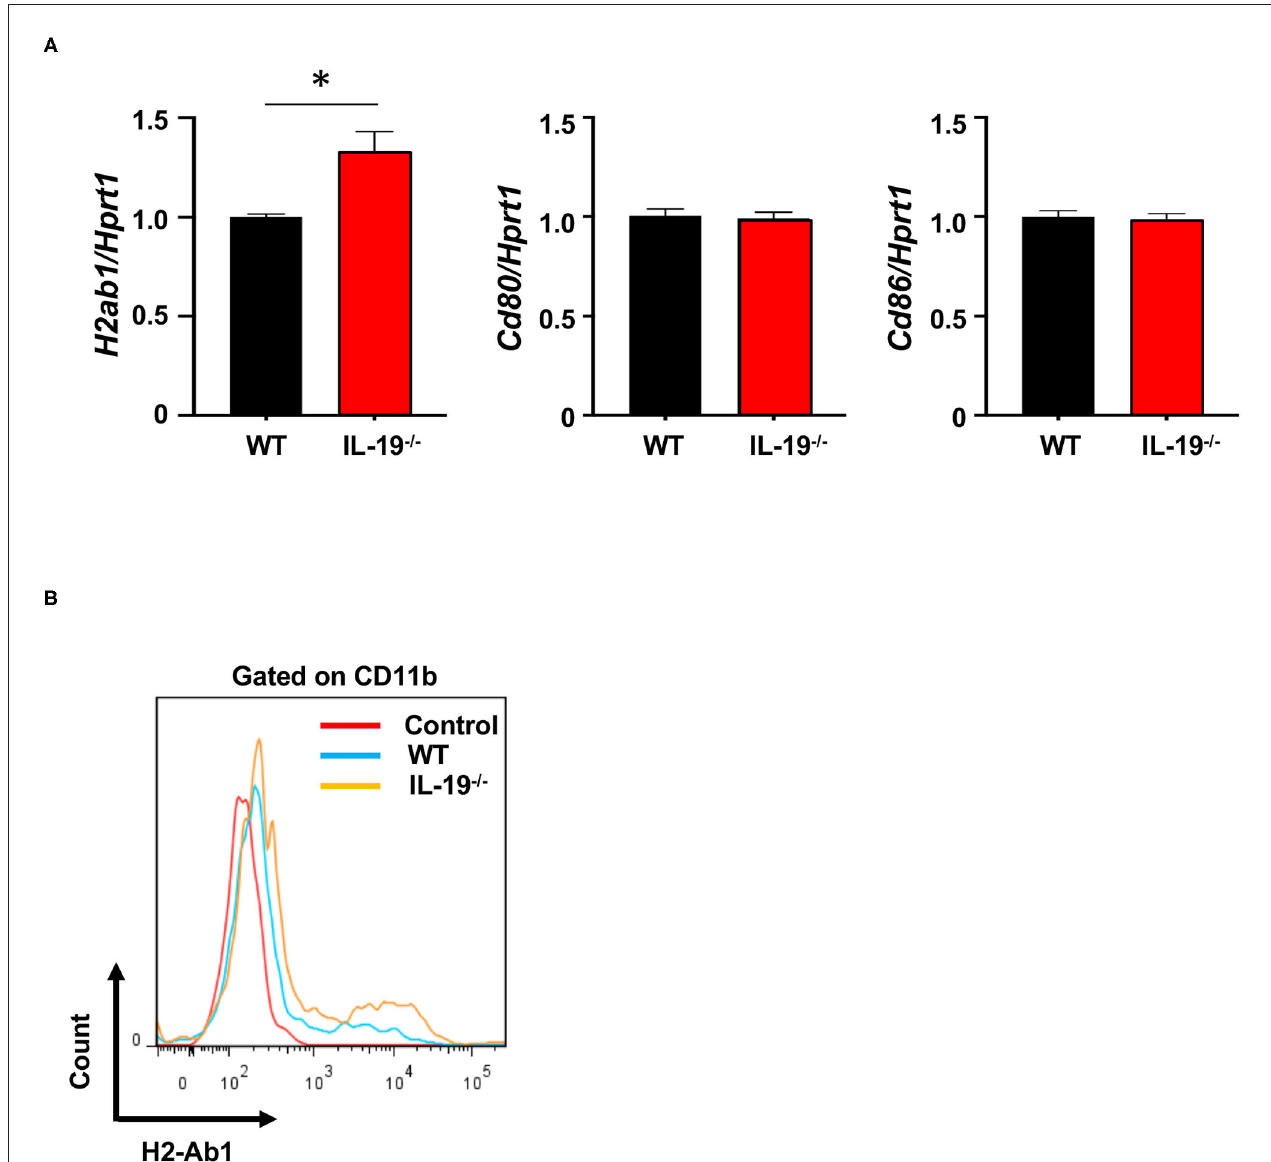
FIGURE 5 | IL-19 deficiency enhances antigen-presenting activity in macrophages. (A) qPCR data for mRNAs encoding MHC class II (H2-Ab), CD80, and CD86 in the splenic macrophages on day 7 after immunization. Data represent means ± SD. * p < 0.05 ( n = 6). (B) Representative flow cytometric data for MHC class II (H2-Ab) presentation in splenic